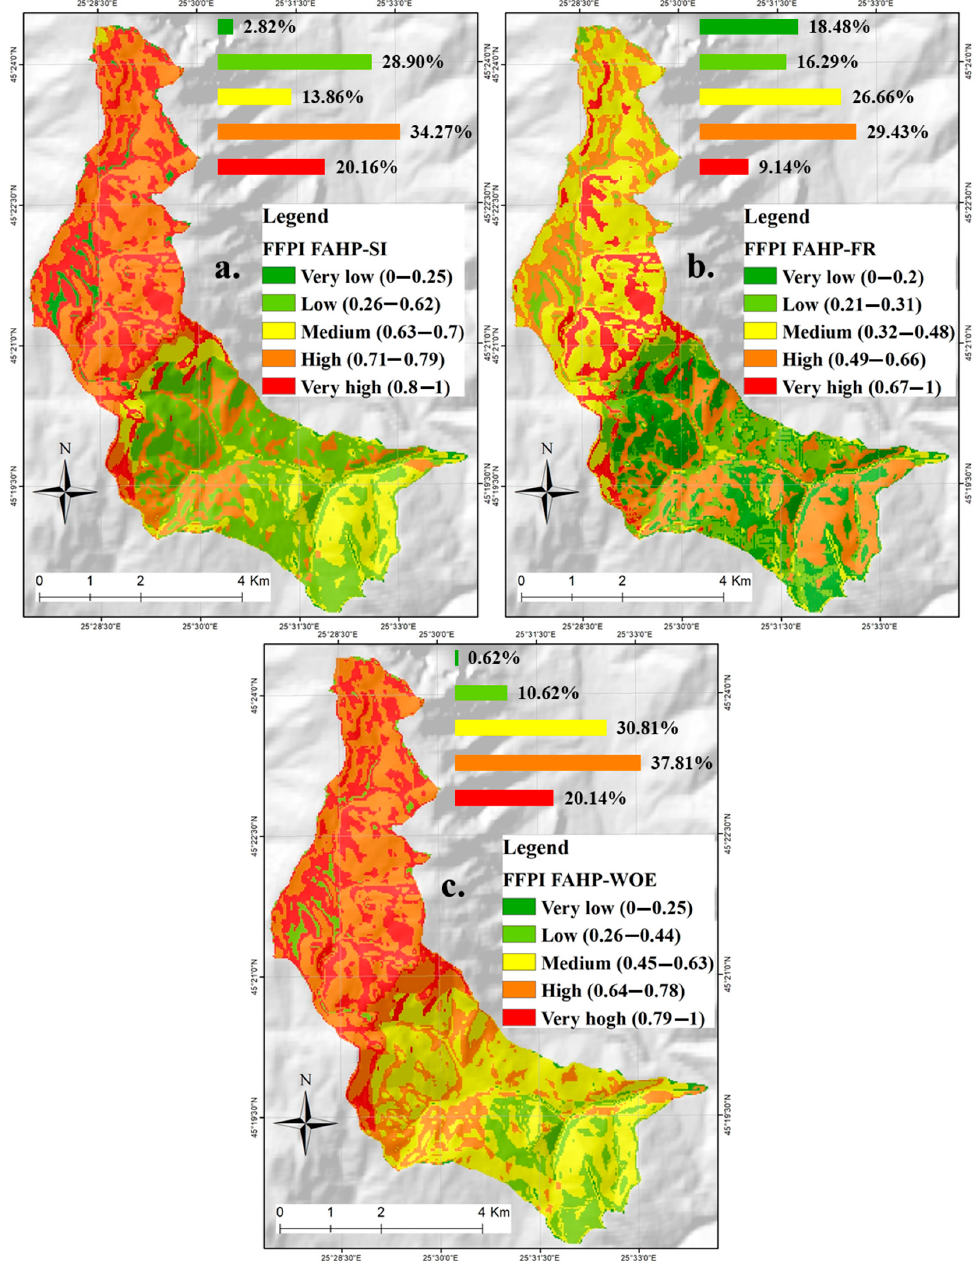
Figure 6. Flash-flood potential index (FFPI) values. ( a ) Fuzzy Analytical Hierarchy Process—Statistical Index (FAHP-SI); ( b ) Fuzzy Analytical Hierarchy Process—Frequency Ratio (FAHP-FR); ( c ) Fuzzy Analytical Hierarchy Process—Weights of Evidence (FAHP-WOE).